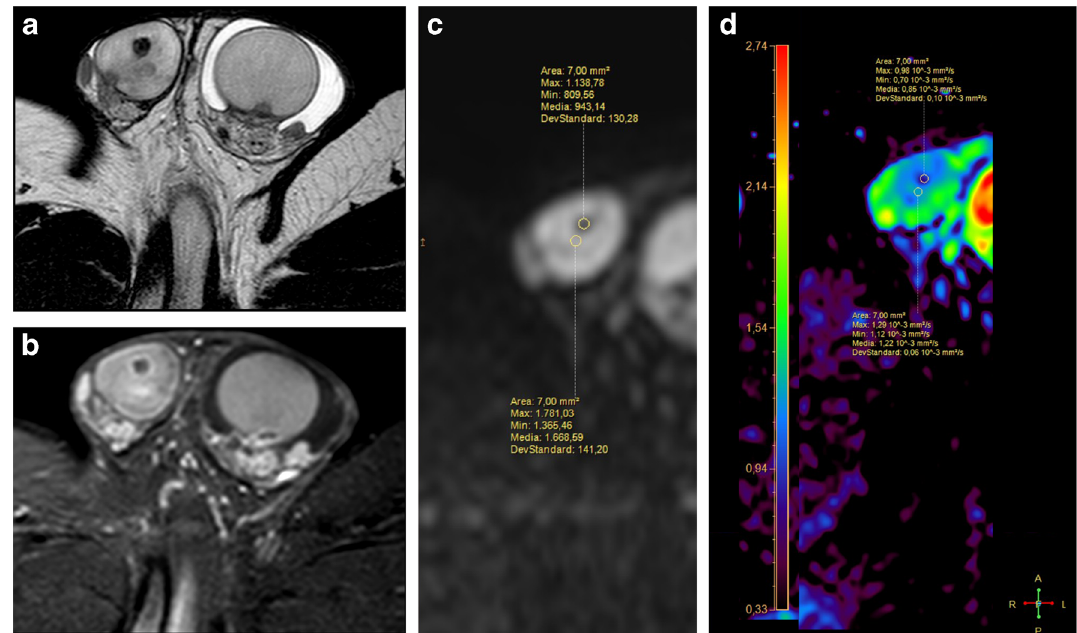
Fig. 6 a - d MR study of a multifocal mixed embryonal carcinoma. a T2-weighted TSE sequence, axial view; b postcontrast T1-weighted SPIR TSE sequence.; c - d